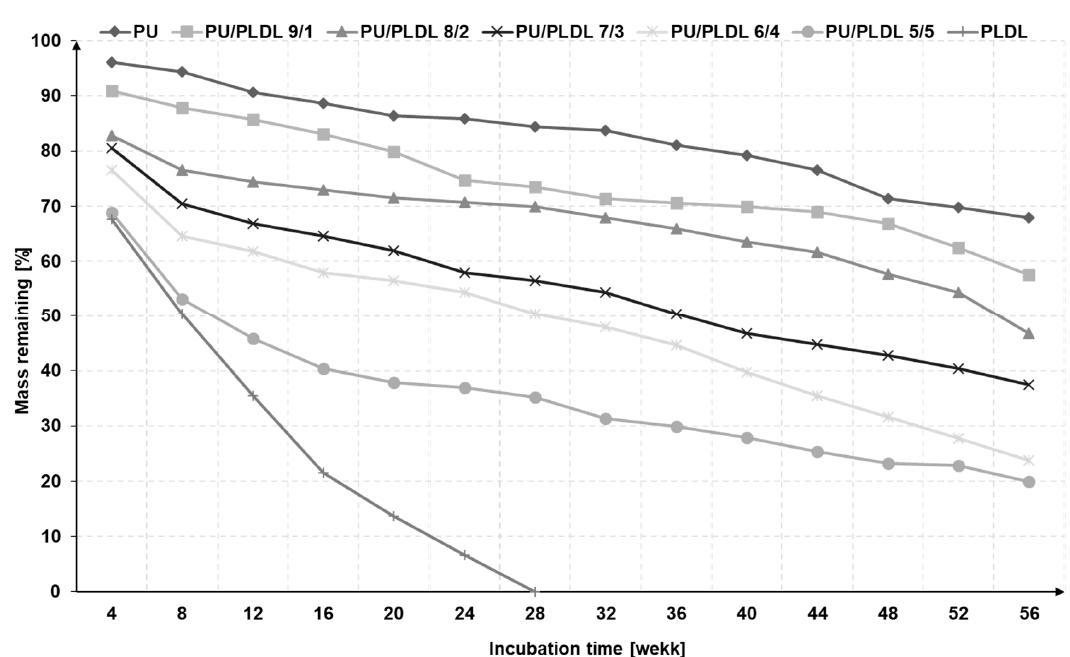
Figure 5. Weight loss of polyurethane, polylactide and PU / PLDL sponges as a function of degradation time in artificial cerebrospinal fluid (ACSF).